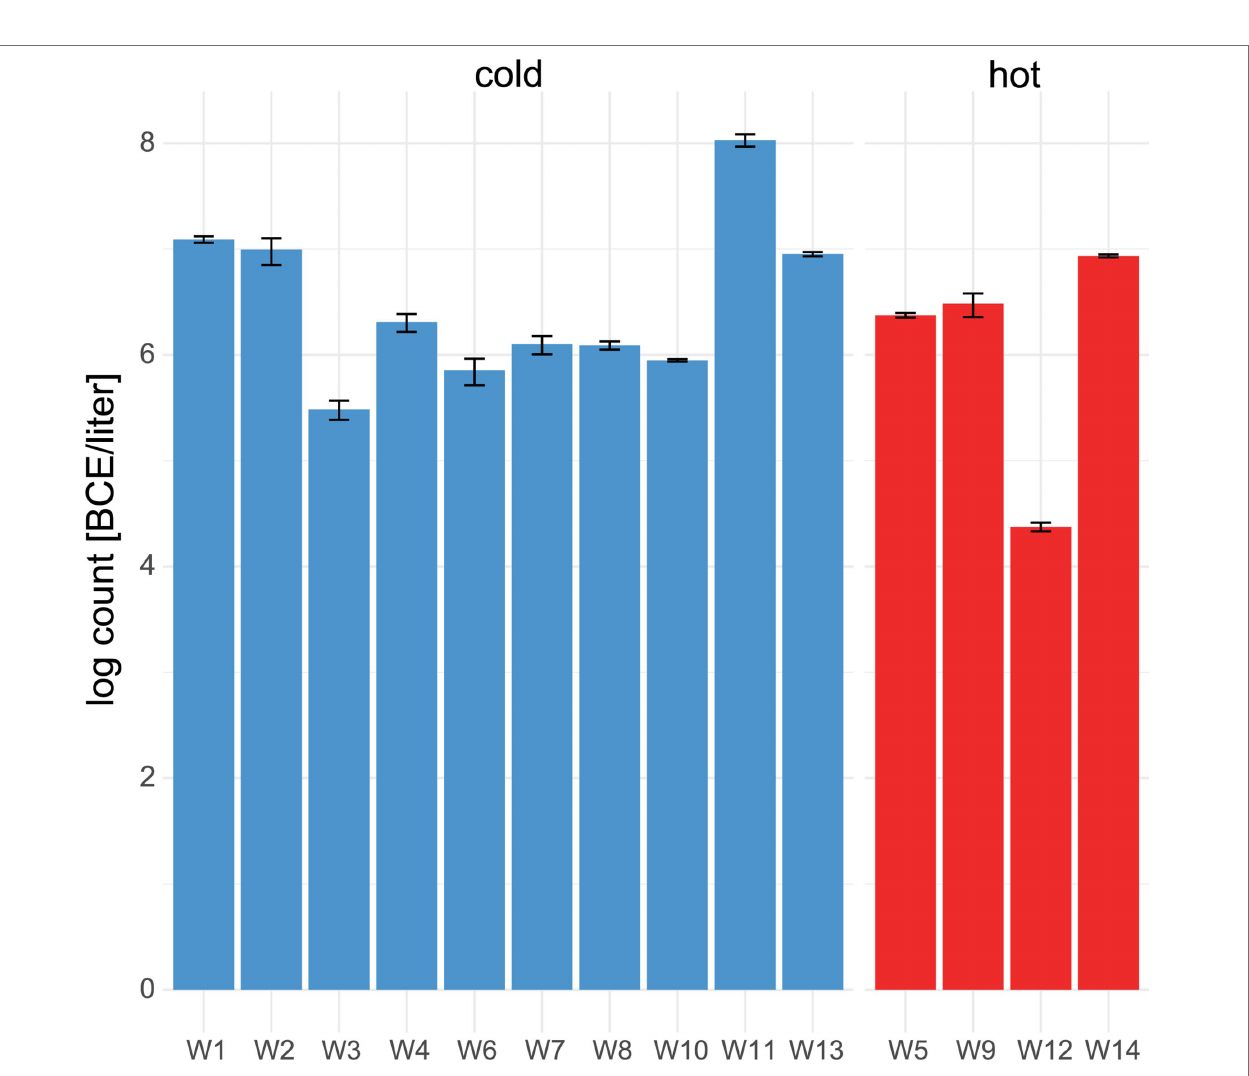
FIGURE 3 | Number of bacterial cell equivalents in water. qPCR assay targeting the 16S rRNA gene was used to determine bacterial cell equivalents in cold (blue) and hot (red) water. Mean values and standard deviation of duplicate measurements are